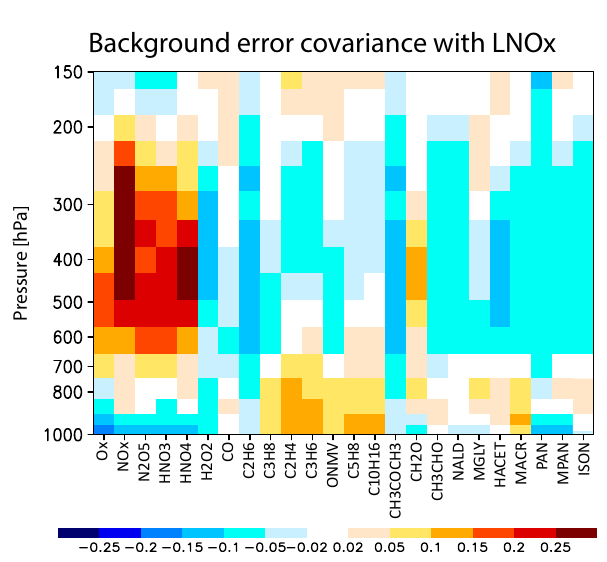
Fig. 3. Vertical profiles of correlations between the LNO x sources and the concentrations of various chemical species as estimated from the background error covariance matrix based on CHASER ensemble simulations, averaged over central Africa for July 2007. The regional monthly mean of the covariance estimated for each grid point is plotted. The correlation is shown in red or blue where positive or negative,